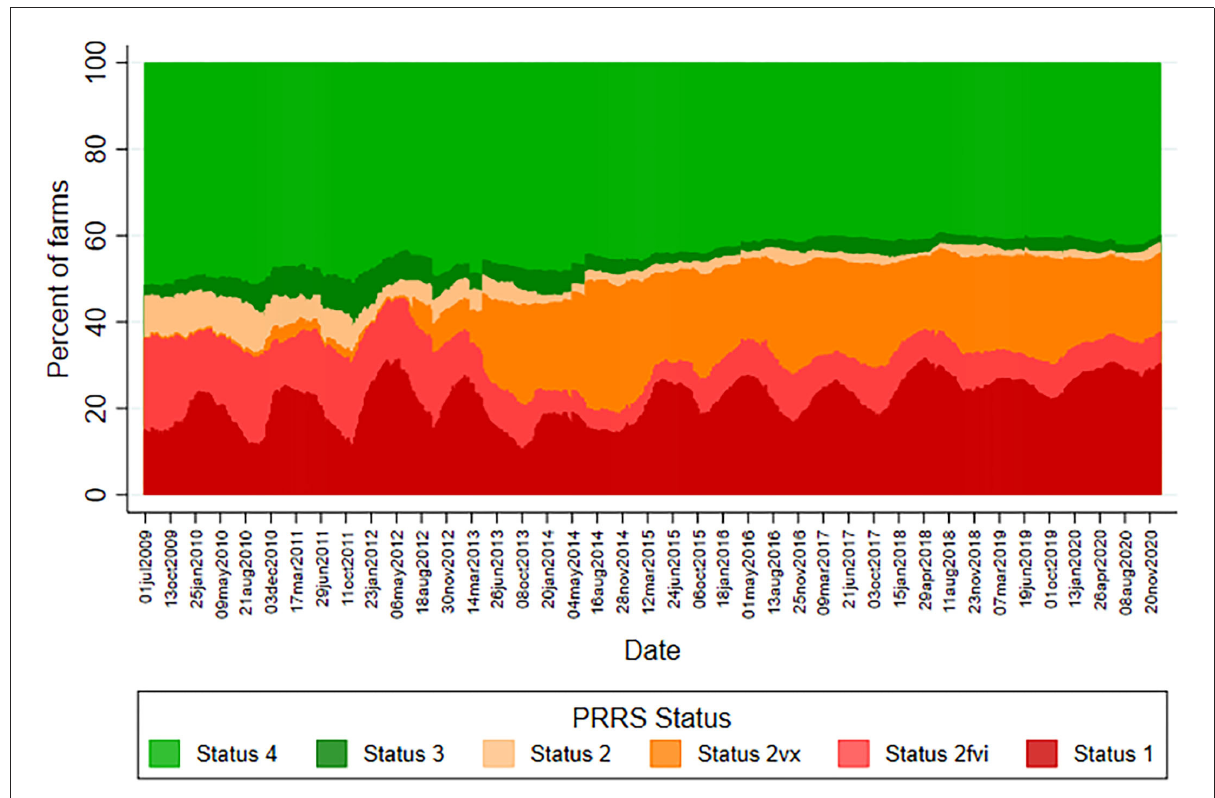
FIGURE1 PRRS prevalence of United States sow herd status from 1,140 herds participating in the Morrison Swine Health Monitoring Project beginning July 01, 2009.